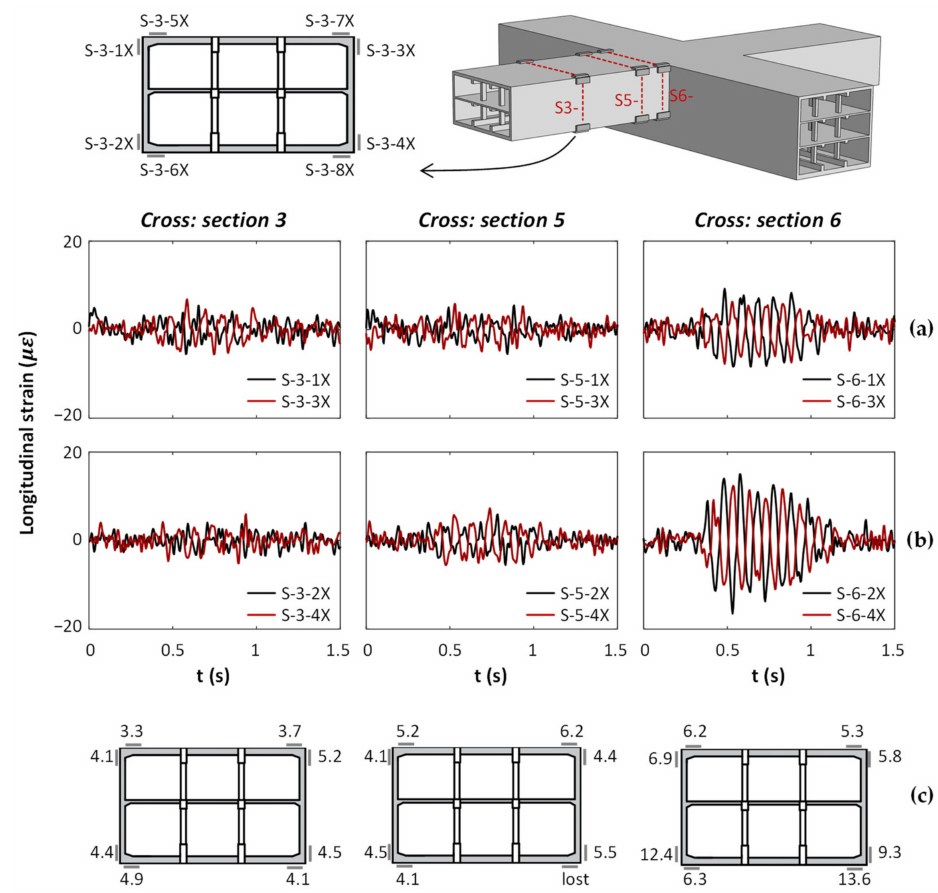
Figure 11. Dynamic longitudinal strain along the two-story structure, recorded on the outside of the sidewall in section 1 , section 3 and section 5 at the elevation of ( a ) the top and ( b ) the bottom of the sidewall. ( c ) Observed maximum tension strains during the sinusoidal excitation with a dominant frequency of 10